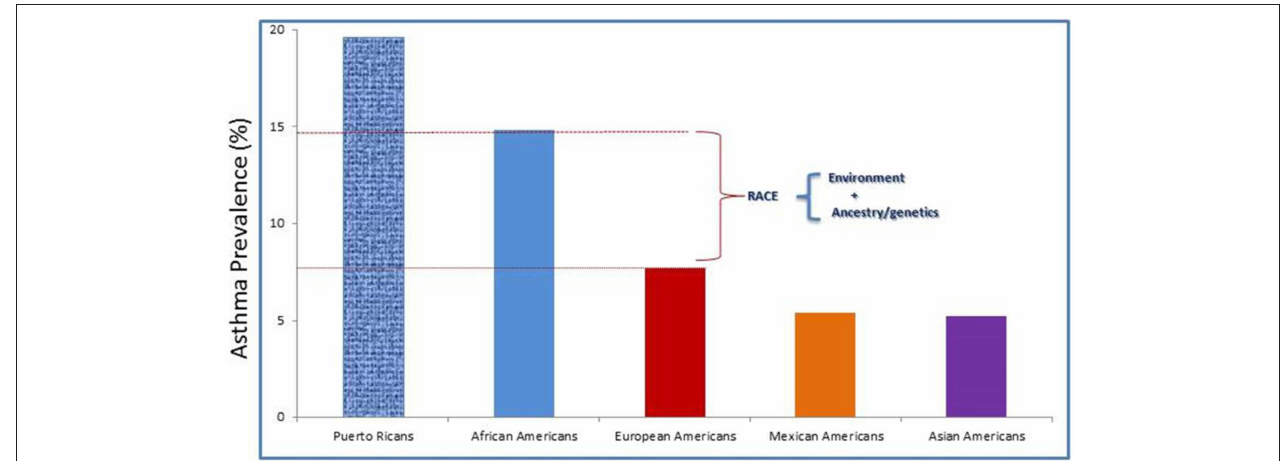
FIGURE 2 | Asthma prevalence rates by race/ethnicity among the U.S. children. Race is considered as risk factor for asthma. But, how much is due to environmental exposures, genetic, and asthma morbidity factors required further studies.